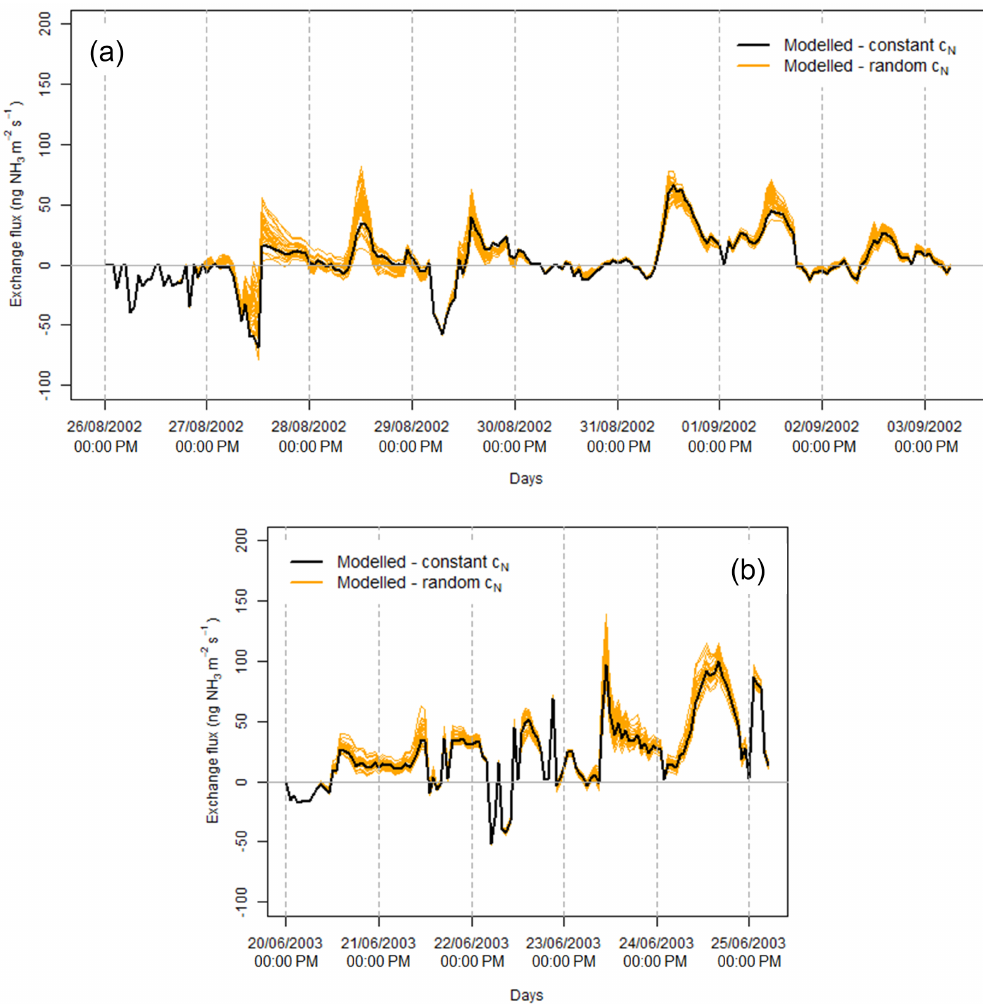
Figure 15. Simulated NH 3 exchange fluxes from the baseline simulation with GAG_field with a constant c N (black line), and 30 model experiments in which c N was randomized for every time step (orange lines) for the modelling periods P2002 (a) and P2003 (b) .